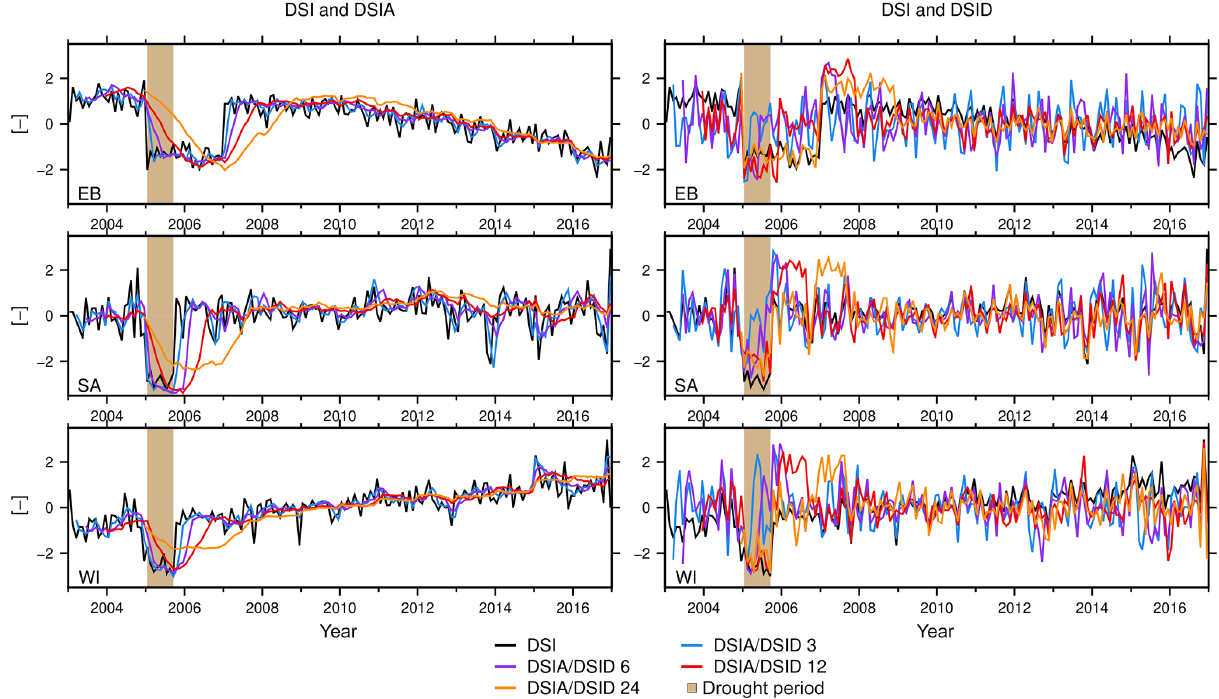
Figure 6. A representative example of the synthetic DSI, DSIA, and DSID (–) for the eastern Brazil (EB), southern Africa (SA), and western India (WI) cluster over the periods of 3, 6, 12, and 24 months. Light brown shows the synthetic constructed drought period.